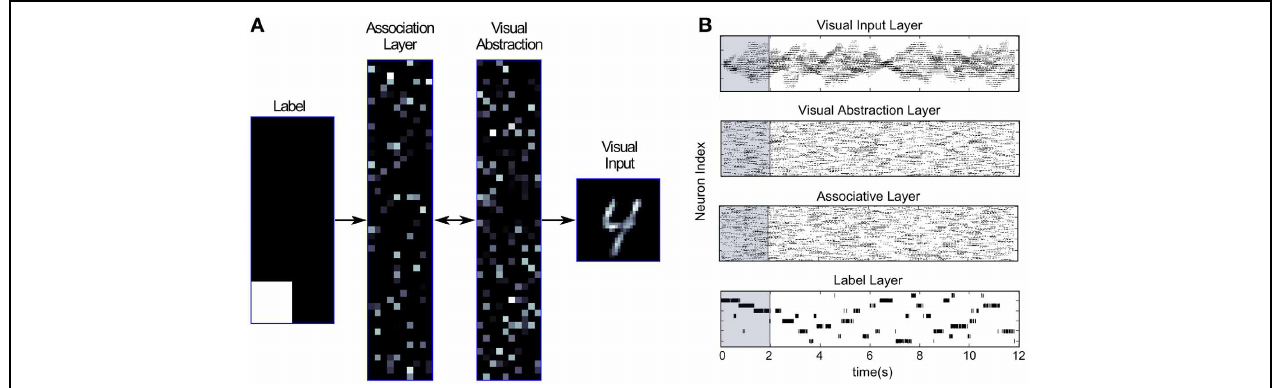
synapses (see Figure 3 ) the network starts to drift through the space of all potential compatible input activations. (B) Raster plot of the DBN in Generation mode. The Label Layer (bottom) is initially stimulated for 2 s (shaded region) to fire in sequence for digits 1, 2, and 3. Afterwards, the network freely samples from the encoded generative model. Although activity in the Label Layer jumps between digits, activity in the Visual Input Layer transitions smoothly.